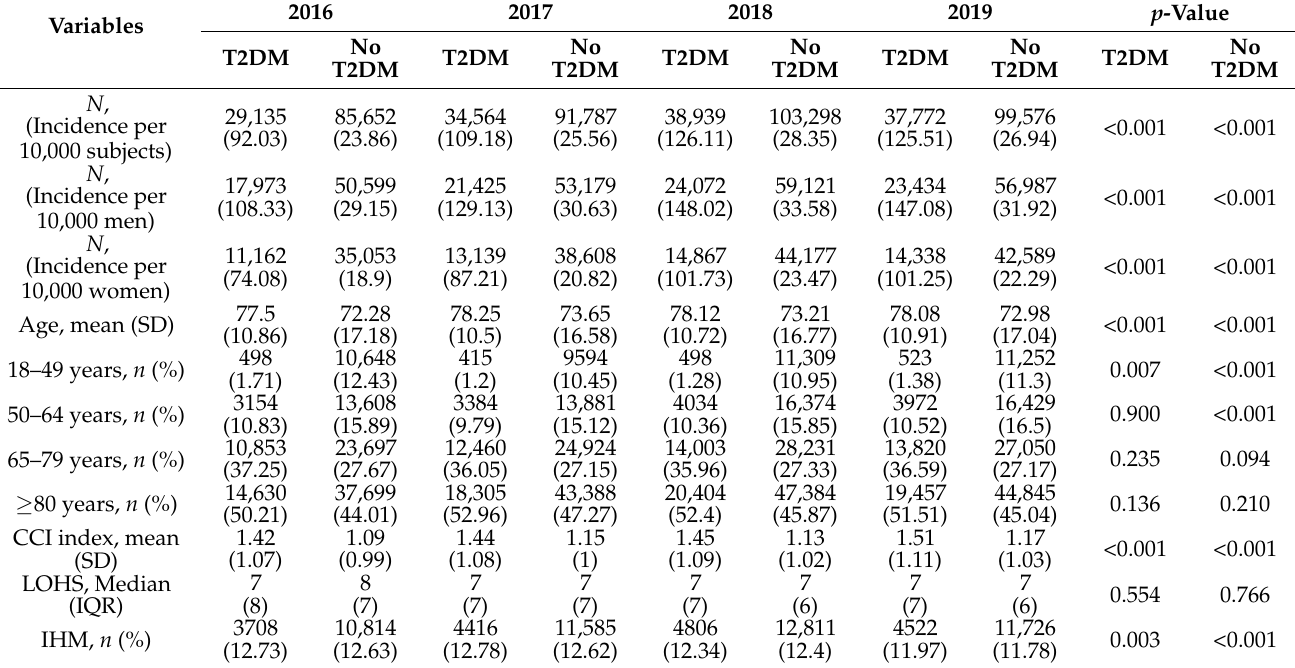
Table 1. Incidence, clinical characteristics, and in-hospital outcomes of patients hospitalized with community-acquired pneumonia (CAP) in Spain from 2016 to 2019 according to the presence of T2DM.